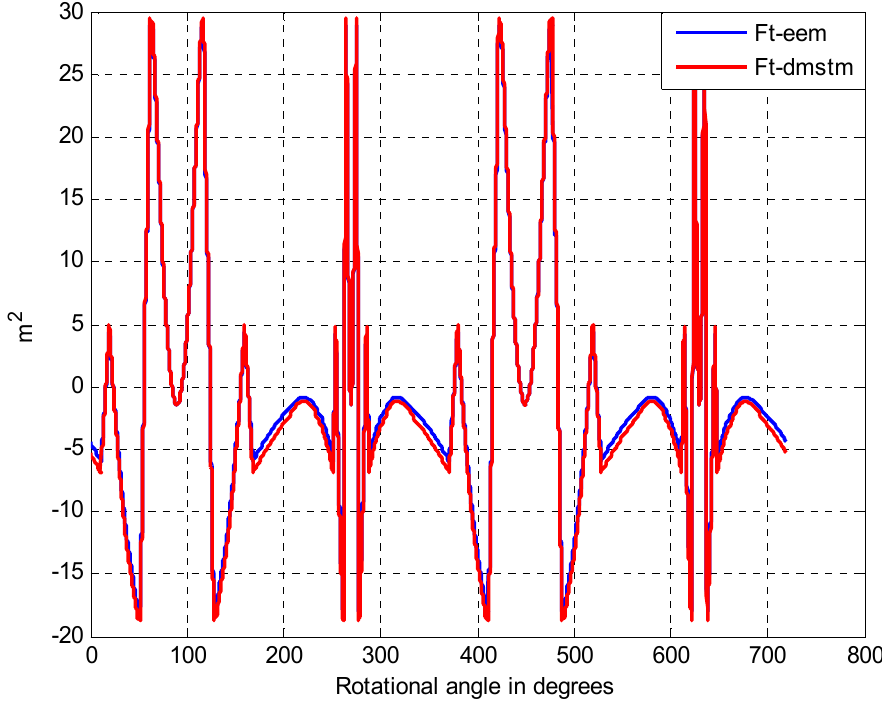
Figure 23. Cross validation of tangential force variations as functions of rotational